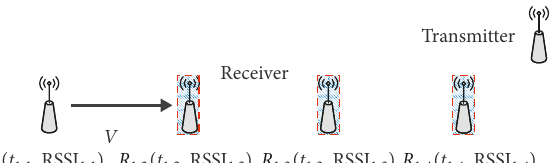
Figure 12: Schematic of the circle trajectory for a moving target.